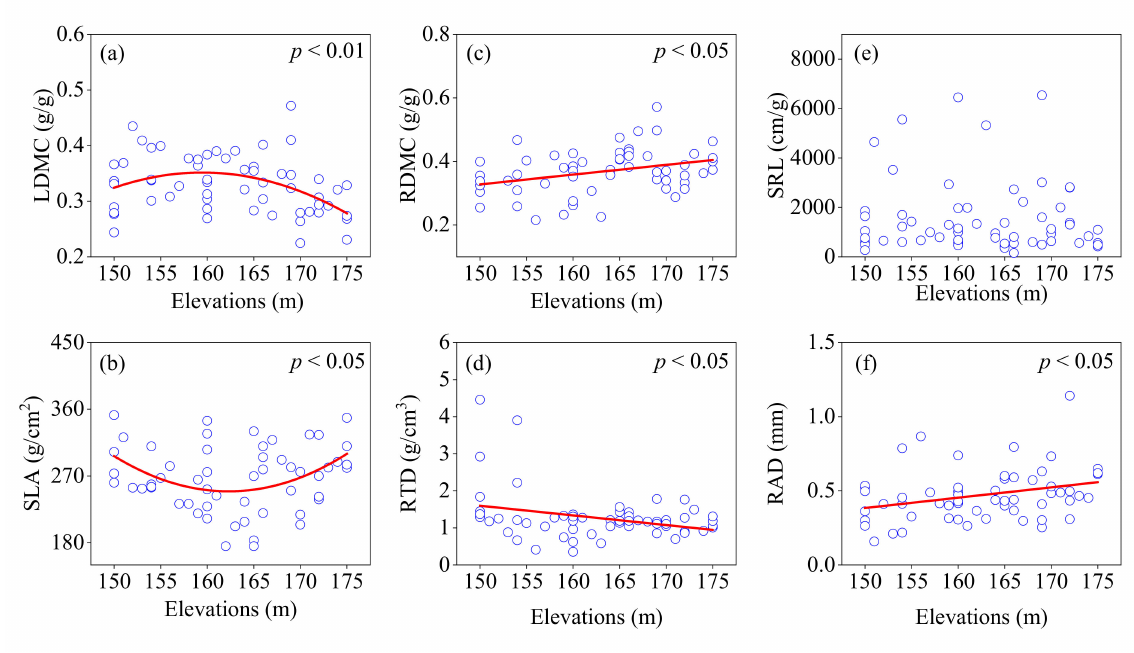
Figure 2. Effect of elevations on the community weighted mean (CWM) traits values of leaf dry matter content (LDMC) ( a ), specific leaf area (SLA) ( b ), root dry matter content (RDMC) ( c ), root